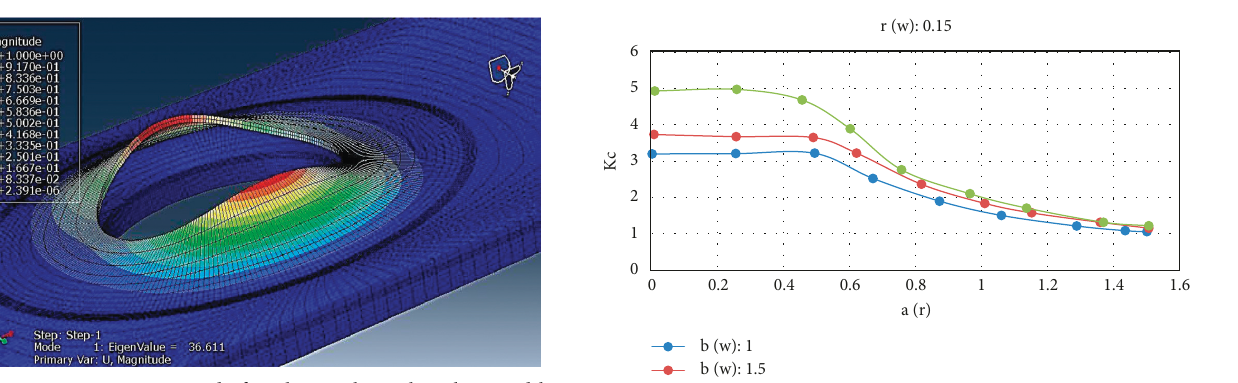
Figure 29: First tension mode for plate with 1/5 length to width ratio and 0/2 radius to width ratio with 1 yielding ratio.